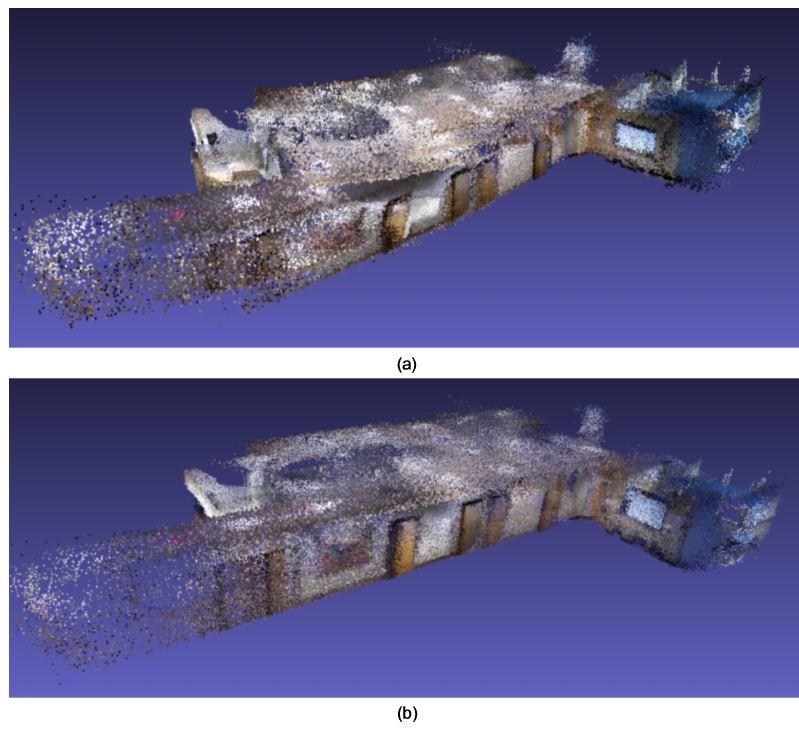
Figure 10. Test result using a corridor environment with multiple rooms. ( a ) Traditional BA [35] cannot recover the whole structure of the corridor environment; ( b ) the proposed method produced a good 3D model for this